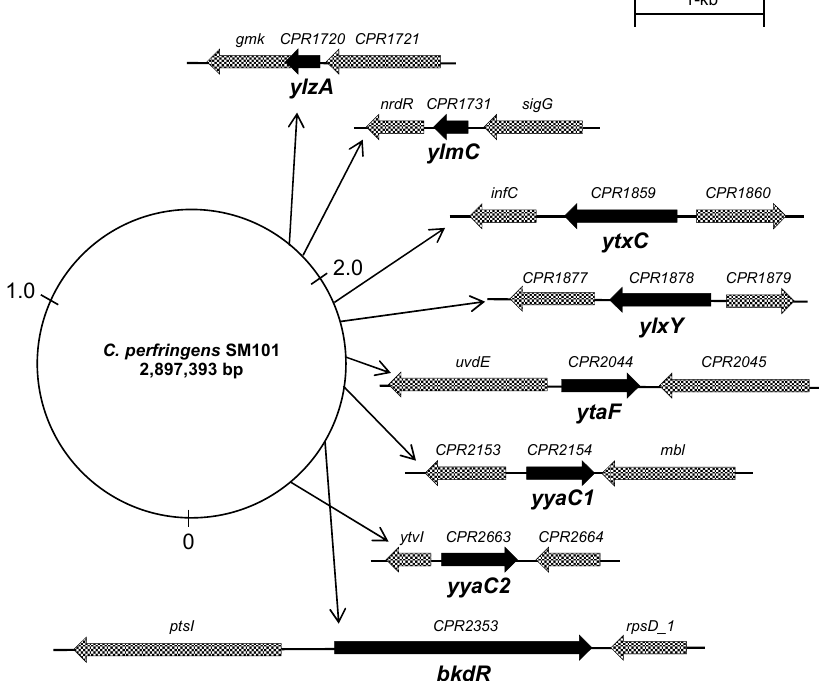
Figure 1. Genomic arrangement of putative sporulation genes in C. perfringens strain SM101. Ar- rangement and position of ylzA , ylmC , ytxC , ylxY , ytaF , yyaC1 , yyaC2 , and bkdR genes are shown in the C. perfringens SM101 genome. The dark arrows indicate the targeted gene that was selected for this study. The dotted arrows represent the upstream and downstream of targeted genes. Thin arrows represent the position of the genes in the SM101 genome.